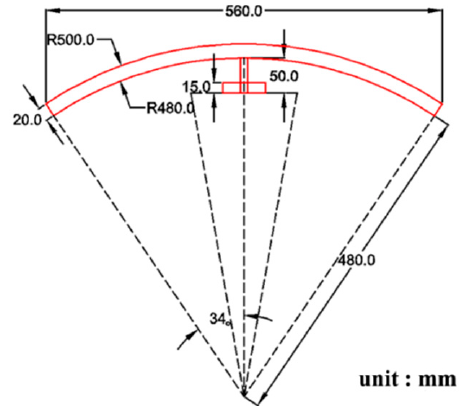
Figure 3. Curved, round rack gear attached to the upper part of the flap.